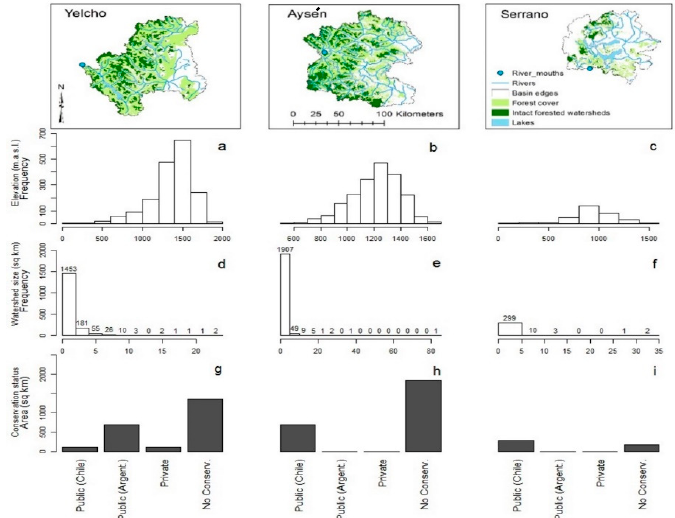
Figure 7. Attributes of intact old growth forest watersheds in the Yelcho, Aysén and Serrano validation basins. Upper maps show spatial distribution represented by light green (all forest types) and dark green (intact IFWs). Frequency distribution of intact IFWs is shown for discharge elevation ( a – c ), watershed area ( d – f ) and conservation status ( g – i ), with public conservation lands for the latter category partitioned between Chile and Argentina.